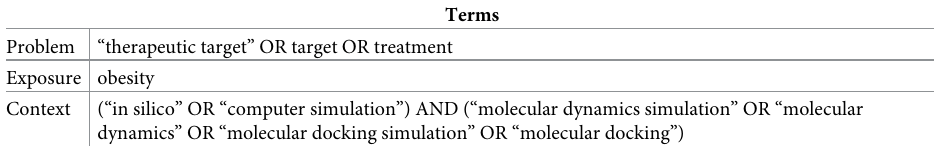
Table 3. Search strategy for the Pubmed database to recover articles to answer the systematic review’s question: What therapeutic targets have been used in in silico analysis for the treatment of obesity?.